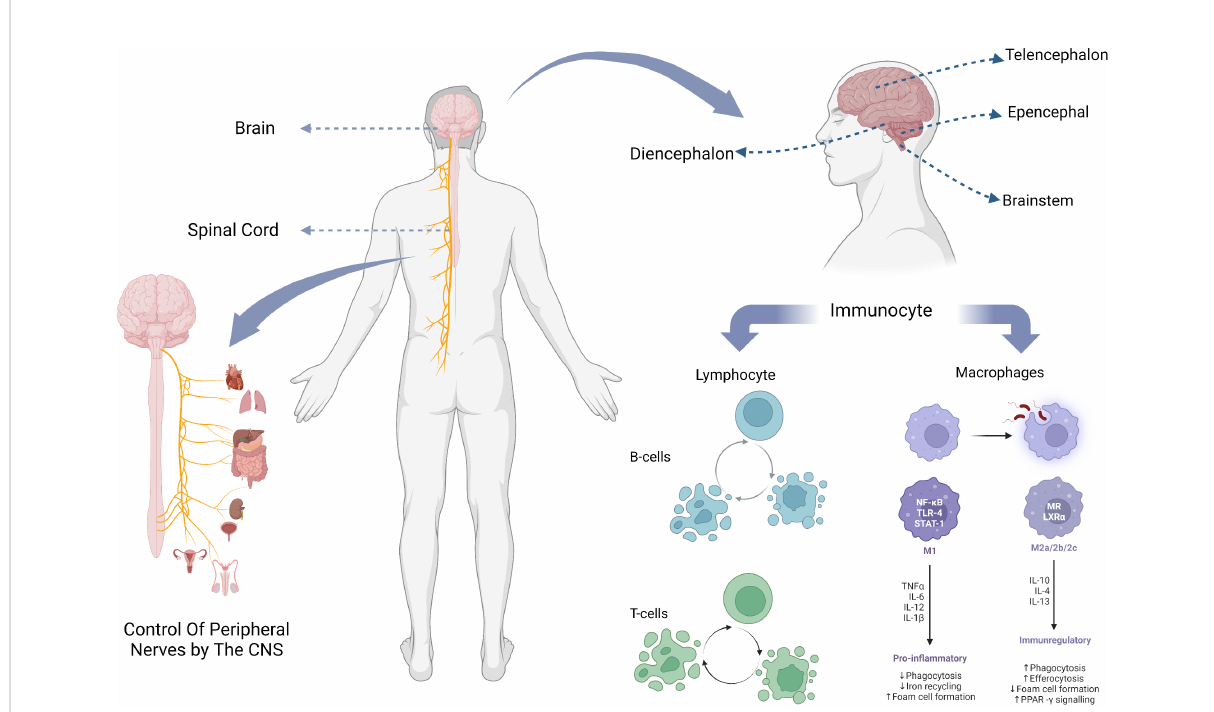
FIGURE 1 The composition of the CNS, the location of its parts, and the major immune cells it